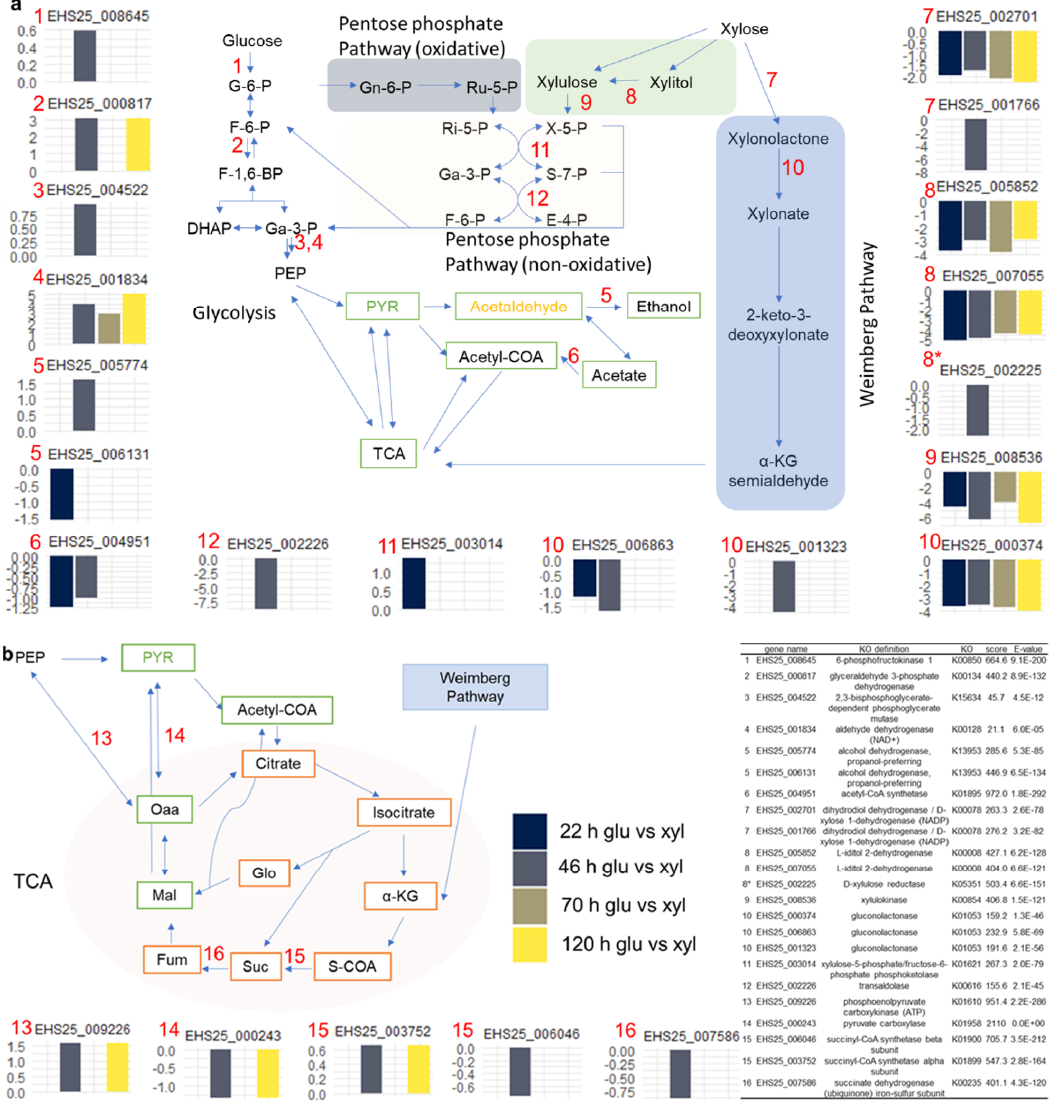
Figure 5. Overview of expression pattern of genes associated with enzymes of the central carbon metabolism of Saitozyma podzolica DSM 27192 on glucose relative to xylose. ( a ) glycolysis, pentose phosphate and putative Weimberg pathways. ( b ) TCA cycle. Differentially expressed genes (FDR < 0.05) are indicated by red numbers in the pathways and bar plots of log2FC values for glucose relative to xylose linked to these numbers. Green and light brown boxes indicate pathways that occur in both cytoplasm and mitochondria, and those occurring exclusively in the mitochondrion, respectively. Figure was adapted from [68] . Asterisk ‘*’ indicates that D -xylulose reductase is also called xylitol dehydrogenase.